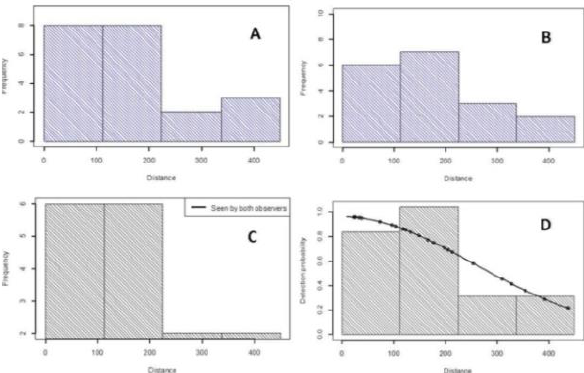
Figure 3. Scaled histograms of perpendicular distances (A, B, C) and the predicted detection probability functions (D) for minke whale groups. A) Front observers, B) rear observers, C) both observers and D) pooled detections with sightings fitted to a half-normal model where each observation prediction is shown as a circle. Distance is measured in meters from the line directly below the aircraft.